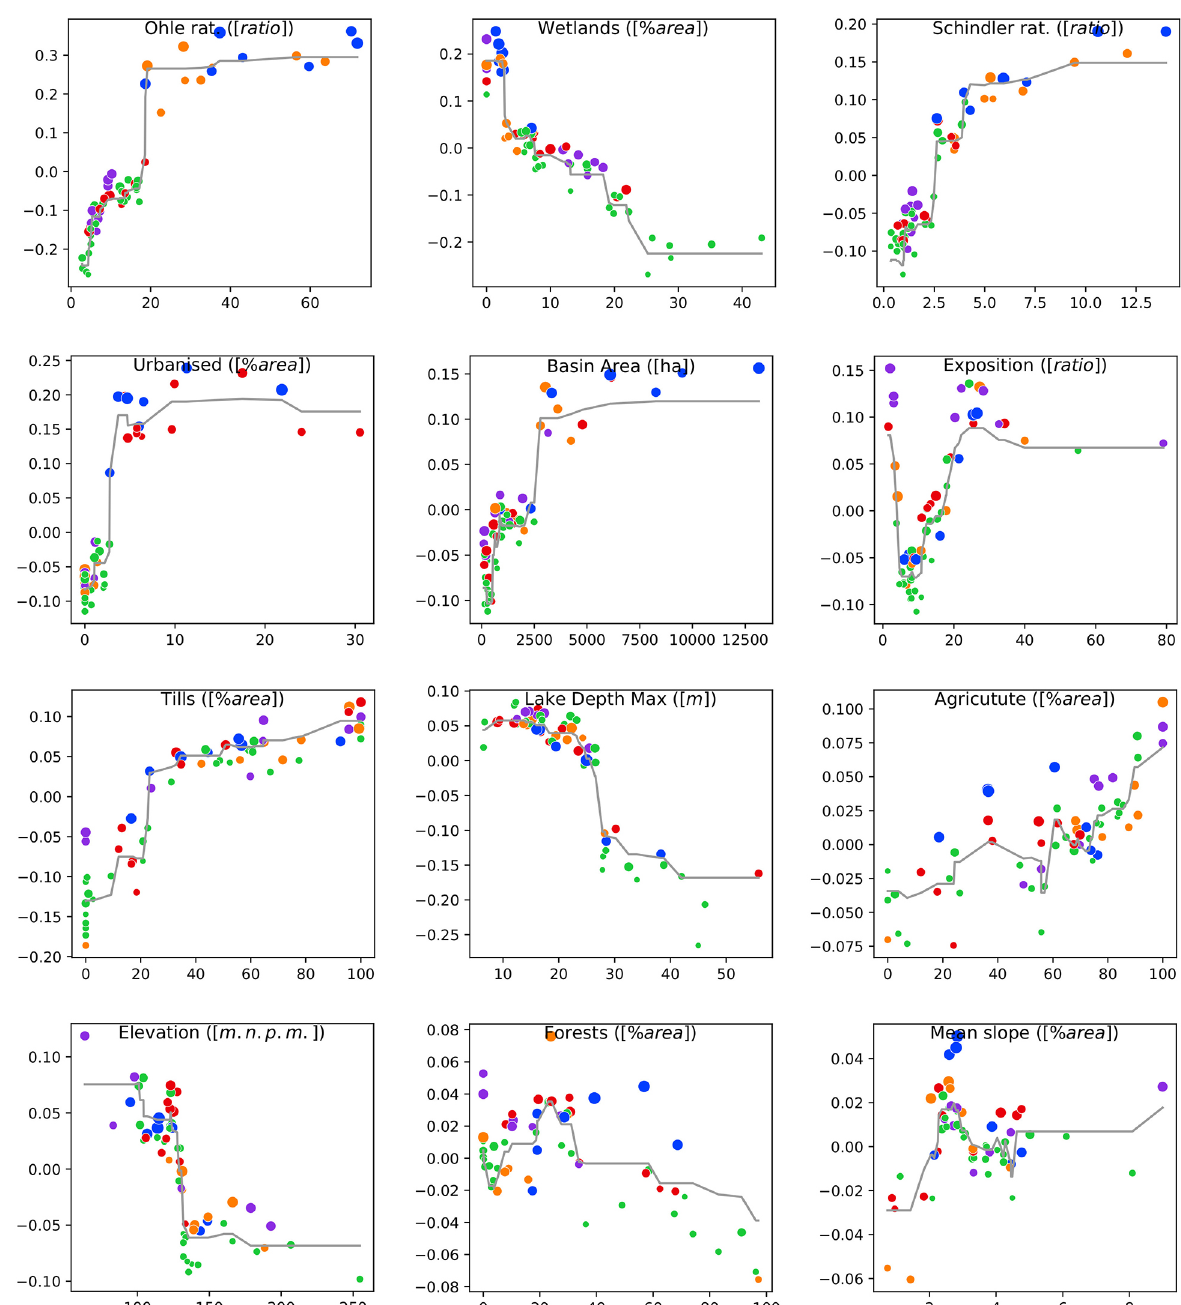
Fig. 8. The influence plots for each variable. The X-axis contains the original values of the variable, Y-axis contains the influence. Colours in legend denote clusters (see Fig. 7), size of dots value of P Dependency Plot (PDP) is marked by a light grey